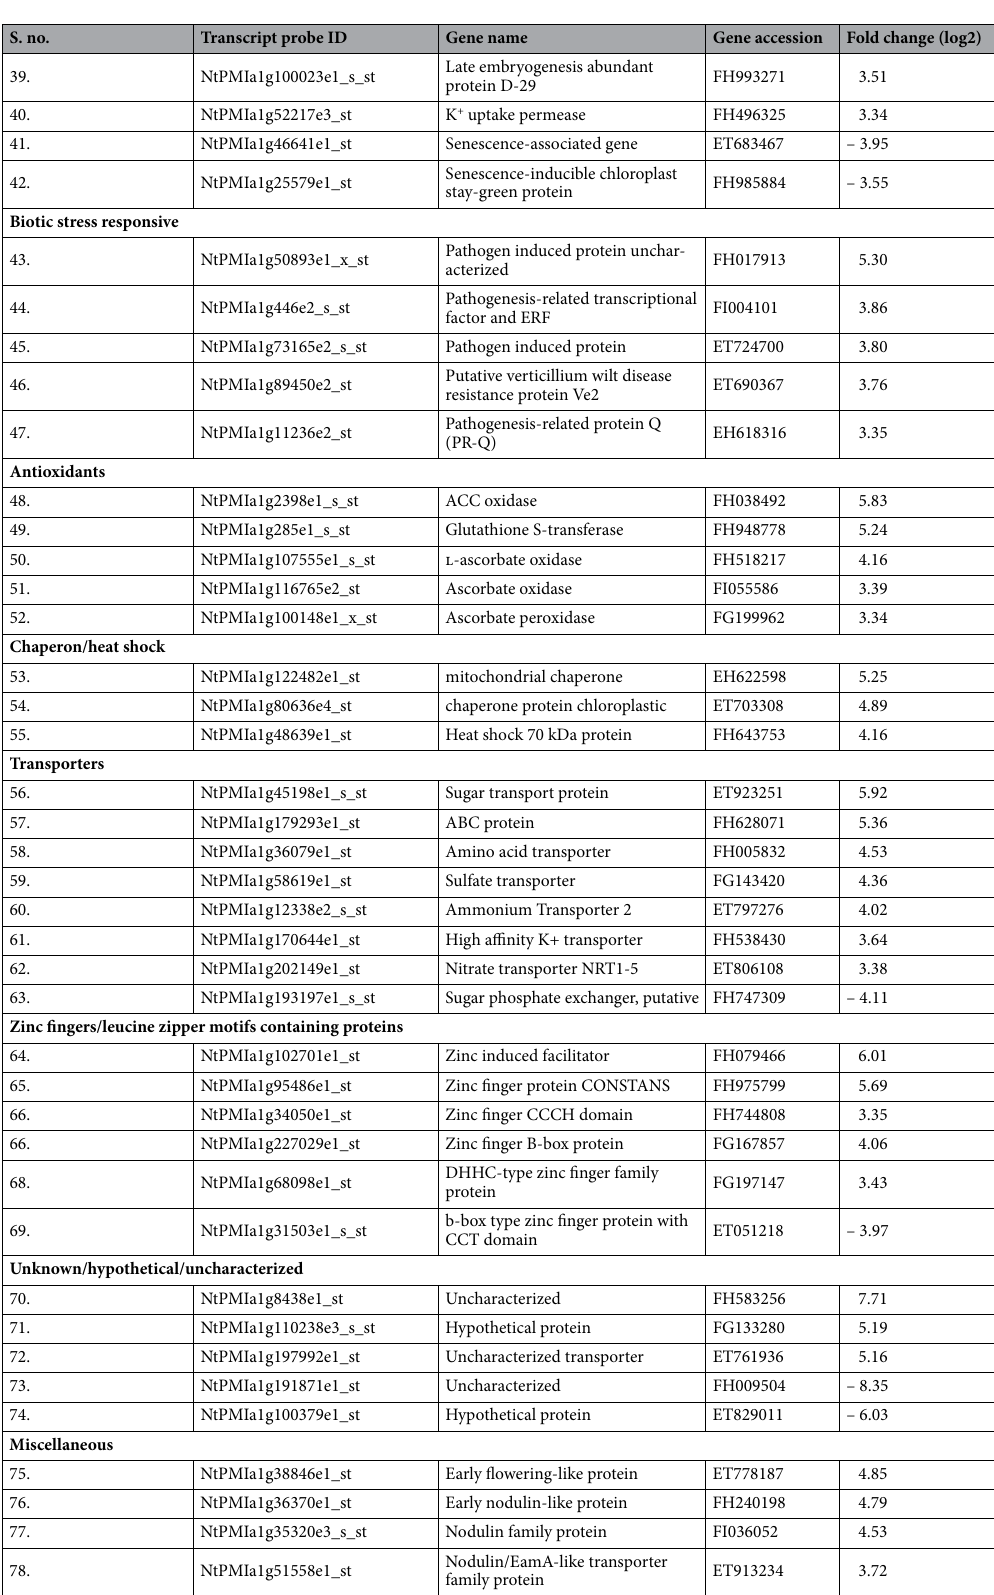
Table 1. Selected transcripts that differentially expressed (up- or down-regulated) in AhCytb6 overexpressing transgenic tobacco plant compared with the wild type under nitrogen deficit or salt stress conditions. No sign indicates up-regulation, whereas “−” sign shows down-regulation. Fold-expression is significant at ANOVA p <